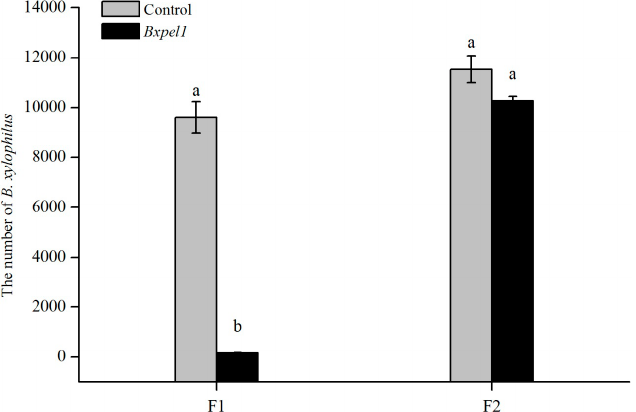
Figure 5. Effects of dsRNAi on B. xylophilus reproduction. Vertical bars indicate standard deviation of the means ( n = 3), and different letters indicate significant differences at a level of p < 0.05 based on